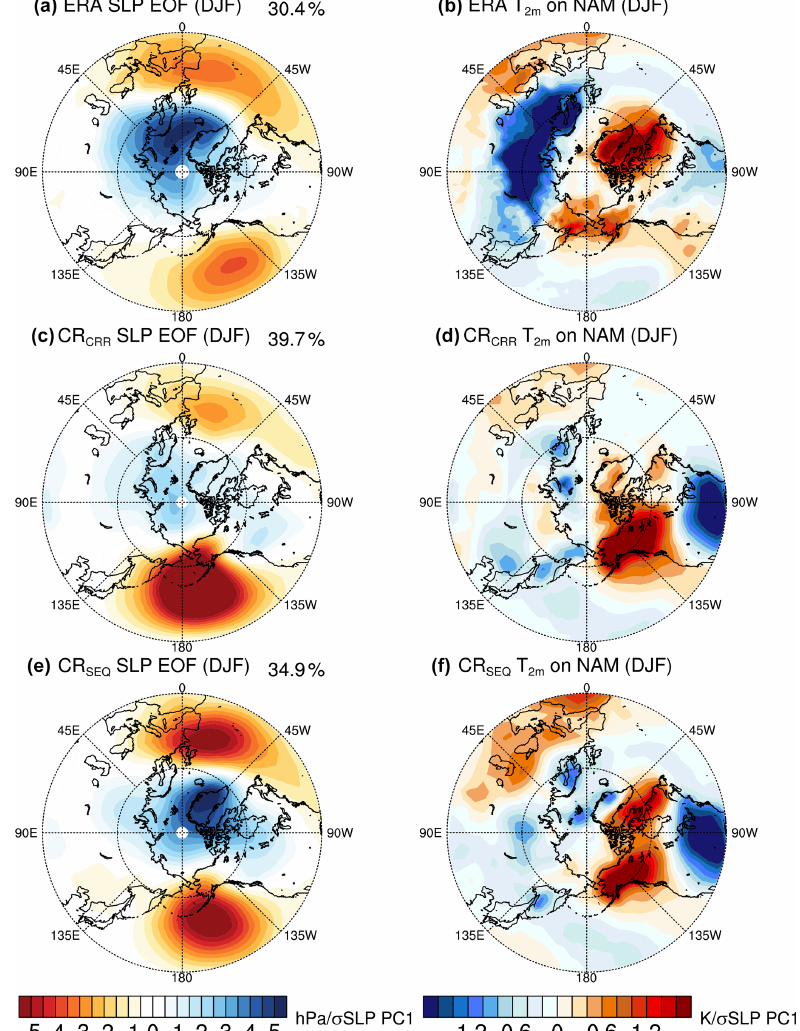
Figure 18. The leading empirical orthogonal functions (EOFs) of December–January–February (DJF) sea level pressure (SLP) anomalies calculated from (a) ERA-Interim as well as the (c) concurrent and (e) classical radiation experiments for the period 1980–2013. Linear regressions of the DJF 2m air temperature on the NAM index (normalized PC1) from (b) ERA-Interim, (d) concurrent, and (f) classical radiation experiments for the period